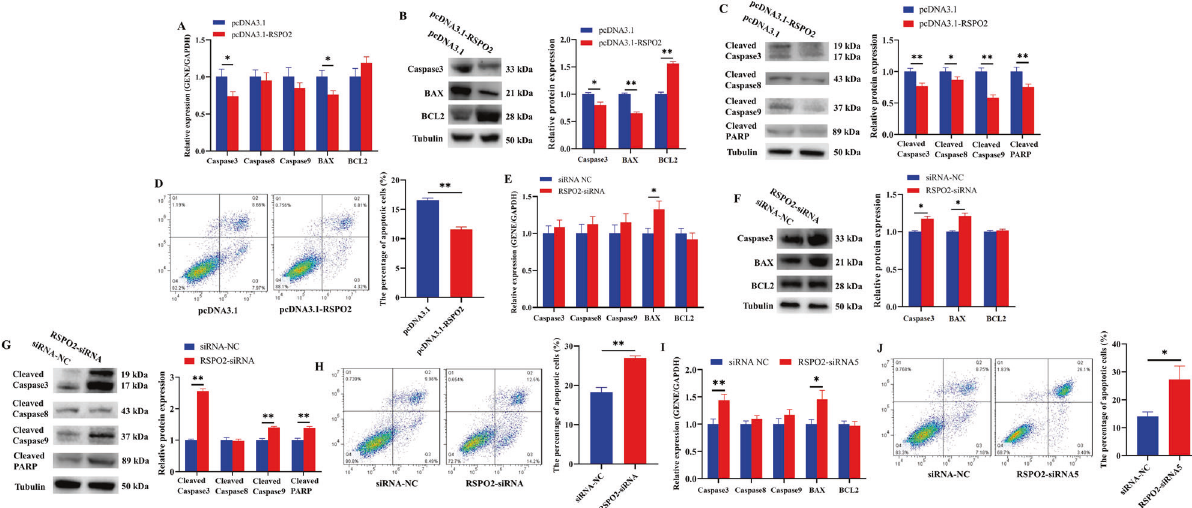
Fig. 3 RSPO2 inhibited the apoptosis of porcine ovarian GCs. A – C The mRNA ( A ) and protein ( B ) expression levels of Caspase3 , Caspase8 , Caspase9 , BAX , and BCL2 , as well as the cleaved protein ( C ) expression levels of Caspase3 , Caspase8 , Caspase9 , and PARP in porcine GCs with RSPO2 overexpression. D The apoptosis rates of GCs with RSPO2 overexpression was assessed by fl ow cytometry. E – G The mRNA ( E ) and protein ( F ) expression levels of Caspase3 , Caspase8 , Caspase9 , BAX , and BCL2 , as well as the cleaved protein ( G ) expression levels of Caspase3